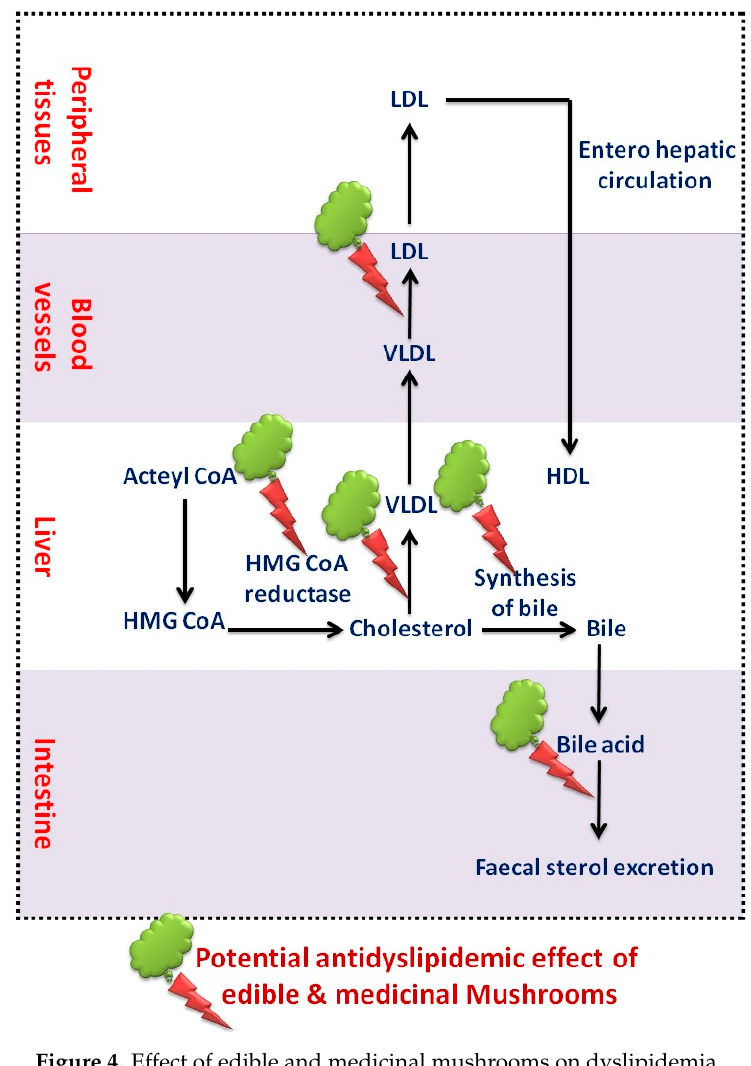
Figure 4. Effect of edible and medicinal mushrooms on dyslipidemia.